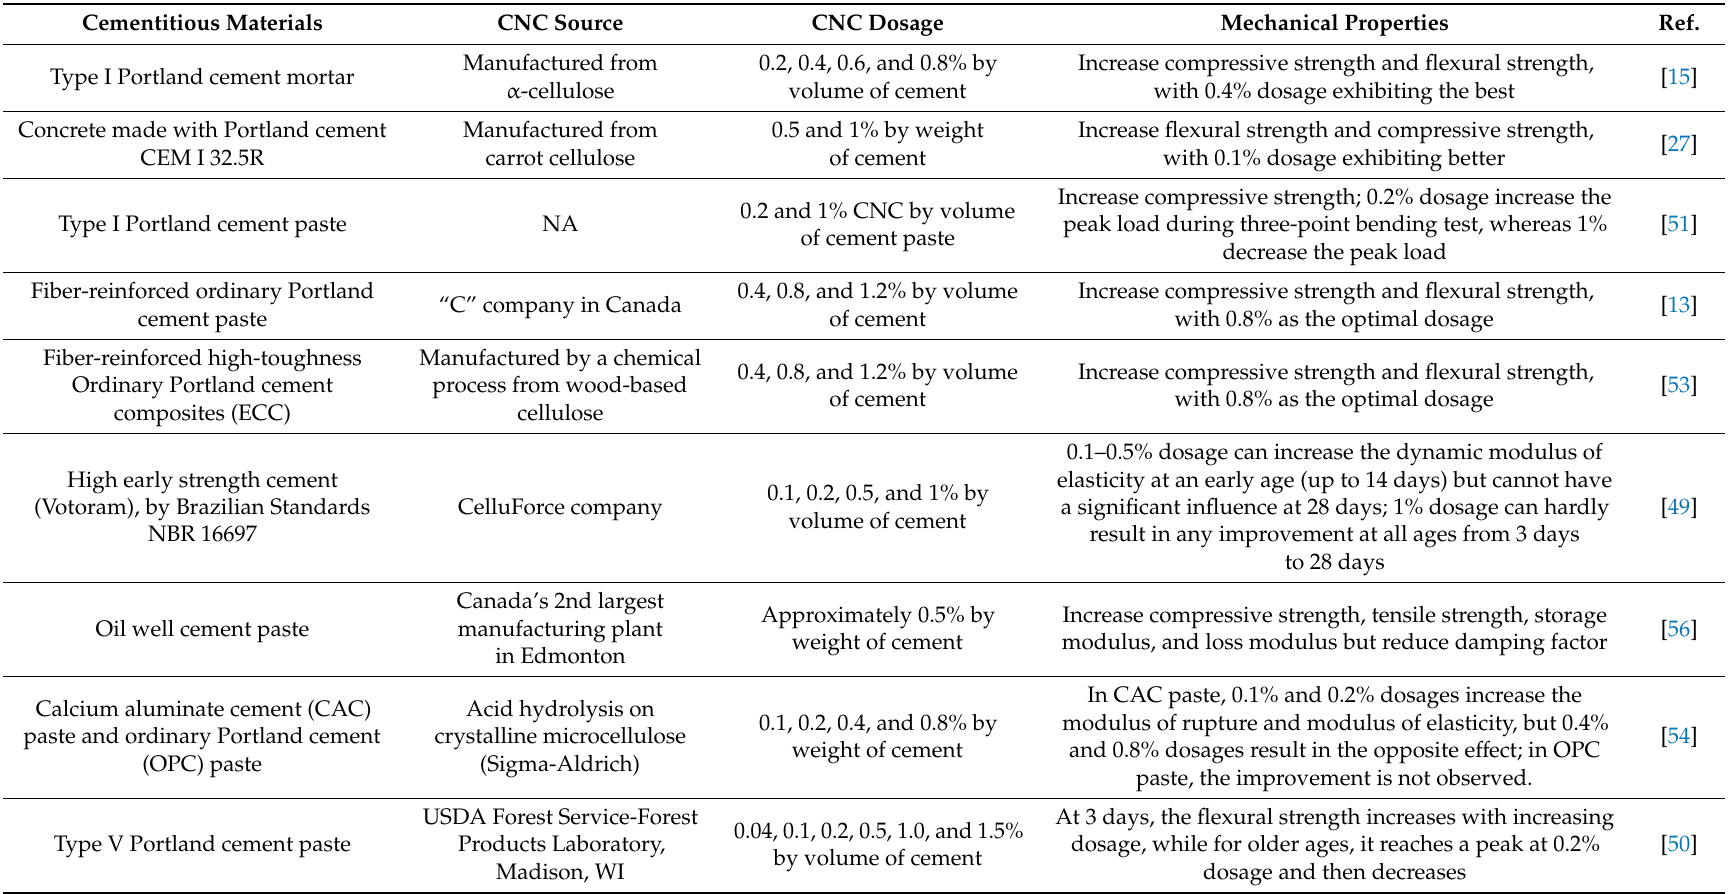
Table 1. Mechanical properties of cementitious materials with